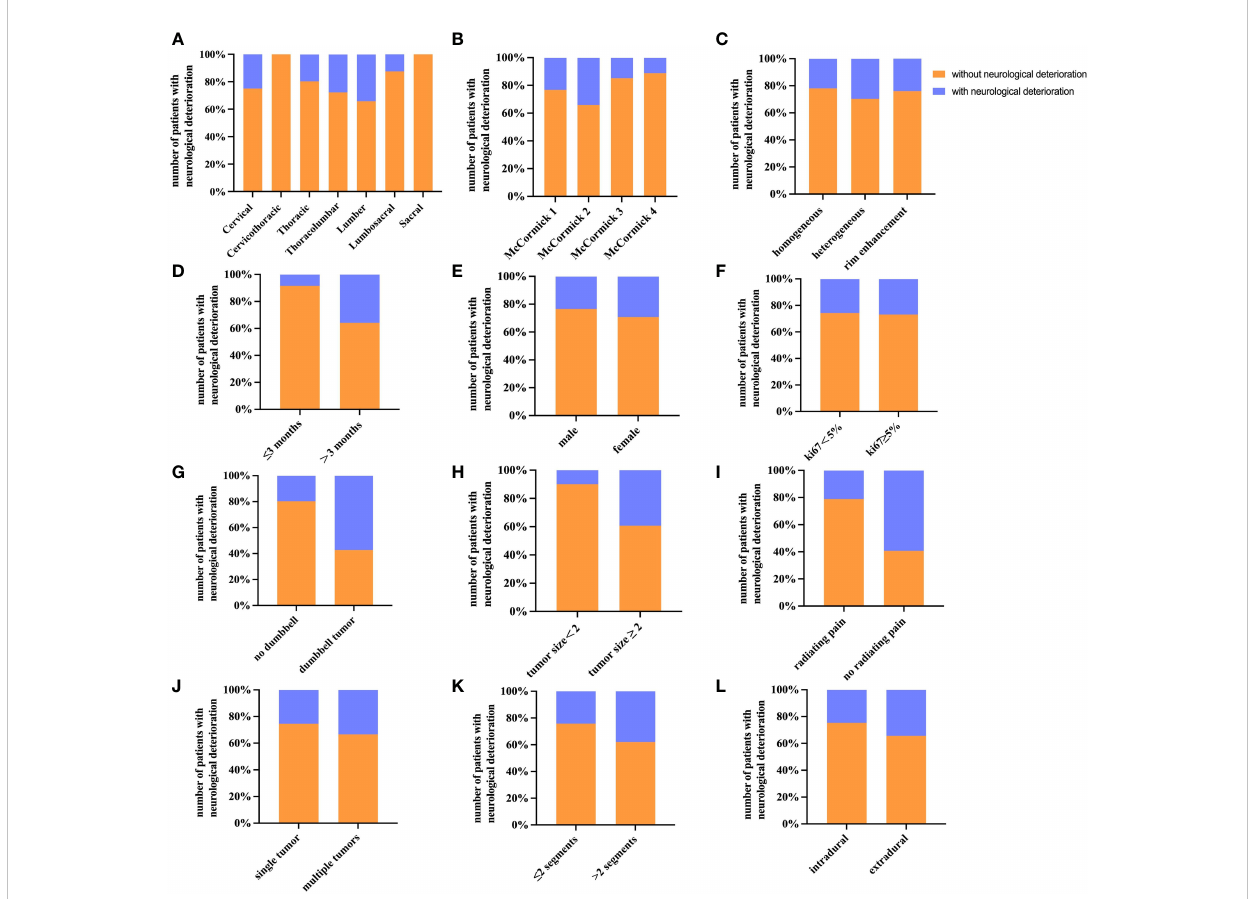
FIGURE 2 Histograms of different factors for patients with postoperative neurological deterioration. The histograms show the number of patients with postoperative neurological deterioration and their percentage. (A) Tumor site (sagittal topography). (B) Preoperative McCormick score. (C) Contrast- enhanced MRI. (D) Duration of symptoms. (E) Gender. (F) Ki67 labeling index. (G) Dumbbell tumor. (H) Tumor size. (I) Preoperative radiating pain. (J) Multiple tumors. (K) Number of involved segments. (L) Tumor